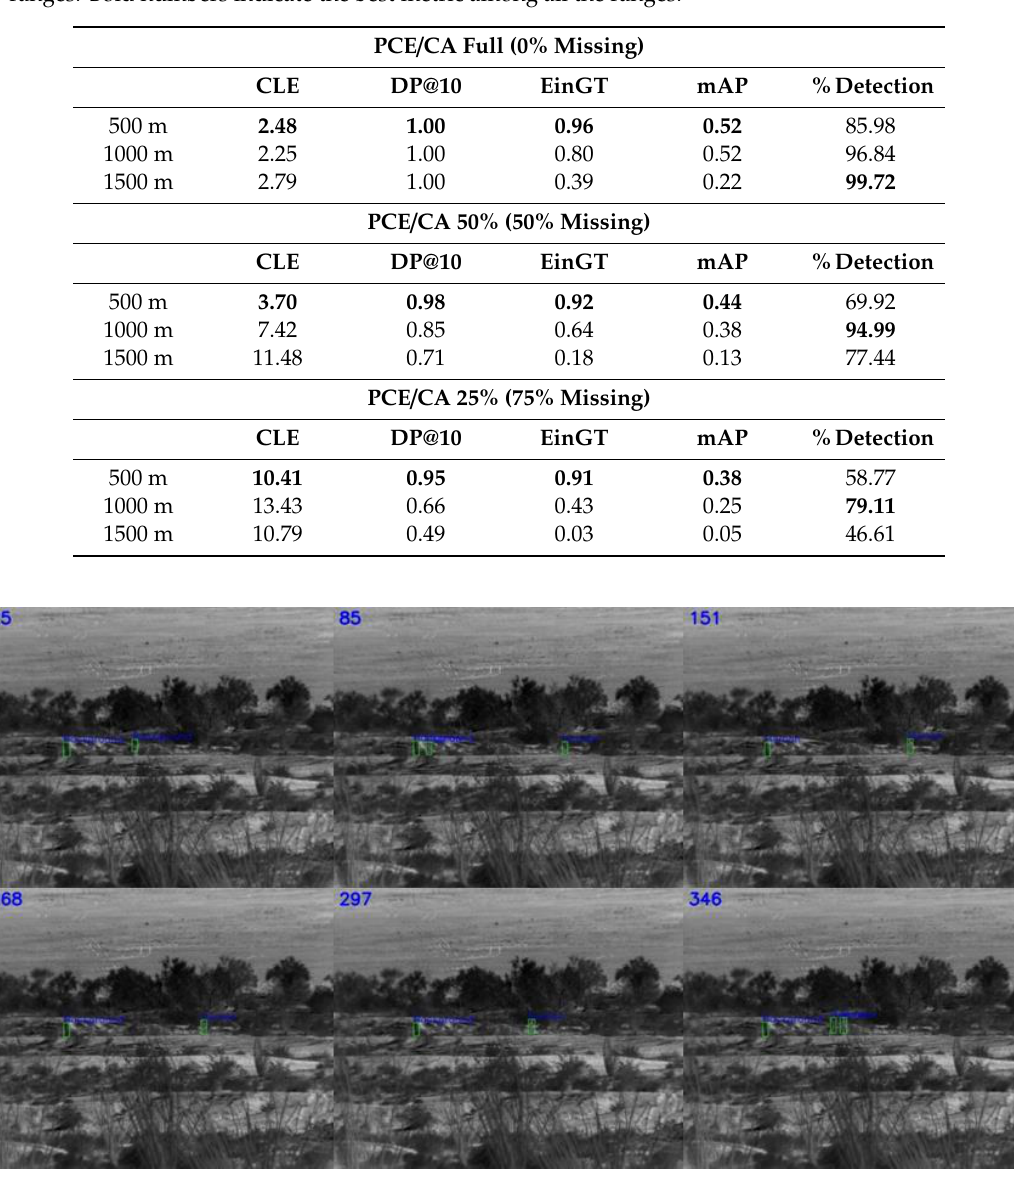
Table 3. MWIR PCE video detection results. Bold numbers indicate the best results among the different ranges. Bold numbers indicate the best metric among all the ranges.